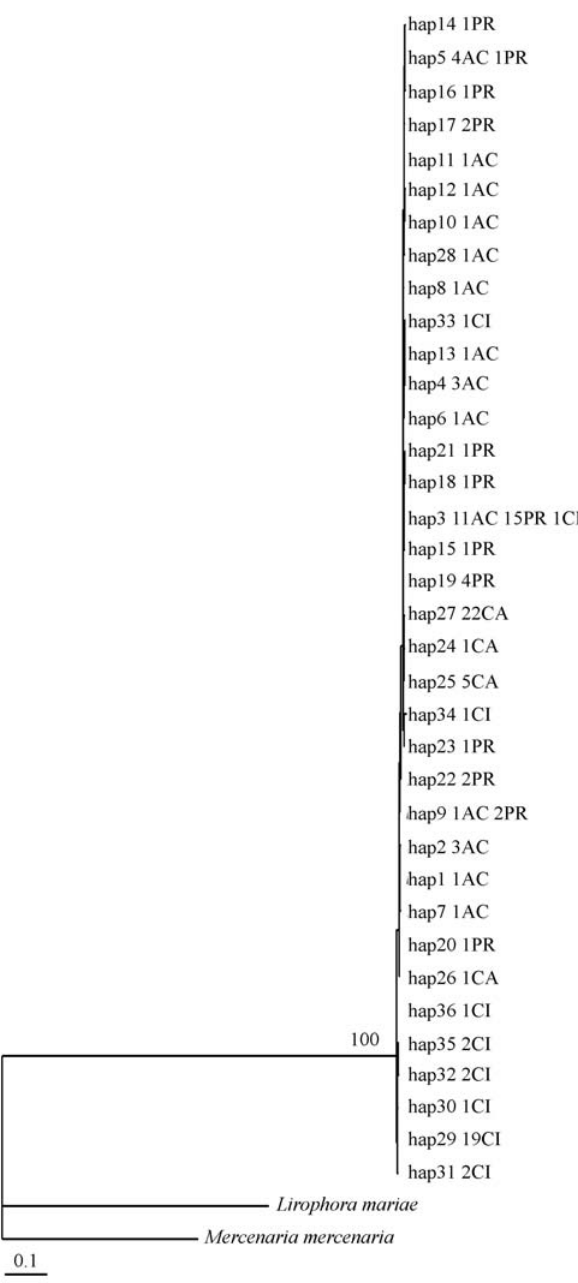
Figure 2 - Maximum likelihood tree obtained from the present analysis of the 36 COI haplotypes of Anomalocardia brasiliana . The number above the branch indicates the only bootstrap value greater than 70%. CA = Camurupim; CI = Canela Island; PR = Prainha; AC = Acupe. Values preceeding abbreviations represent the number of individuals typed for each haplotype.